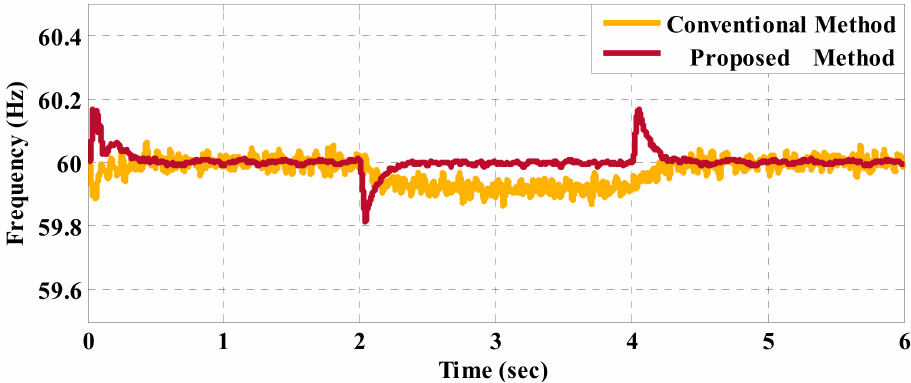
Figure 18. Frequency comparison of the islanded